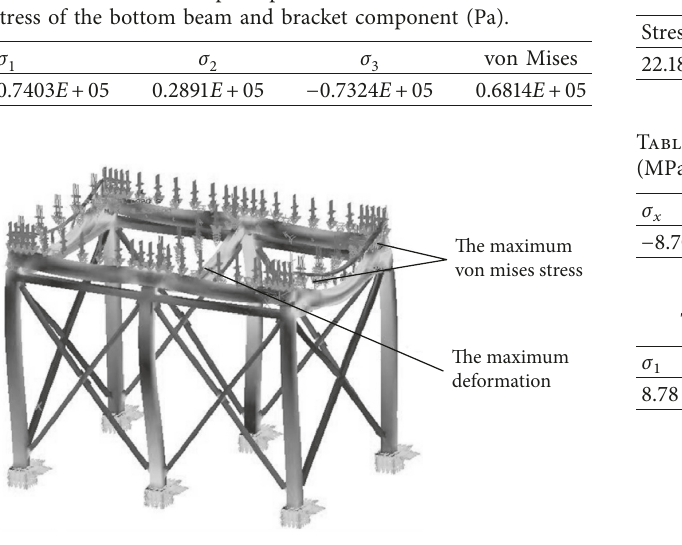
Figure 19: The von Mises stress nephogram of the bottom beam and bracket component (Pa).